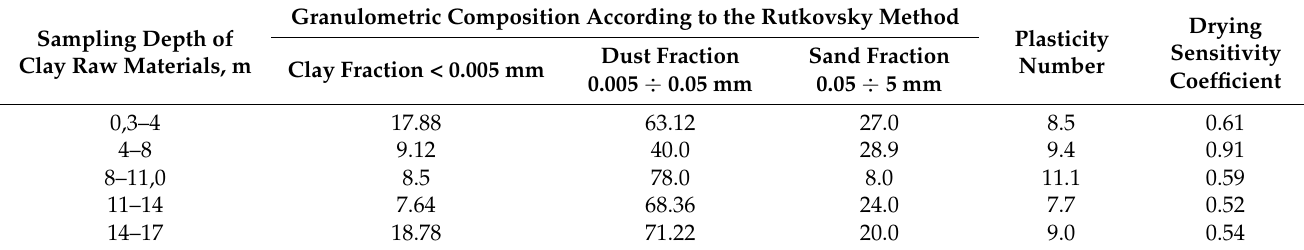
Table 2. Granulometric composition, plasticity, coefficient of sensitivity of loams to drying.